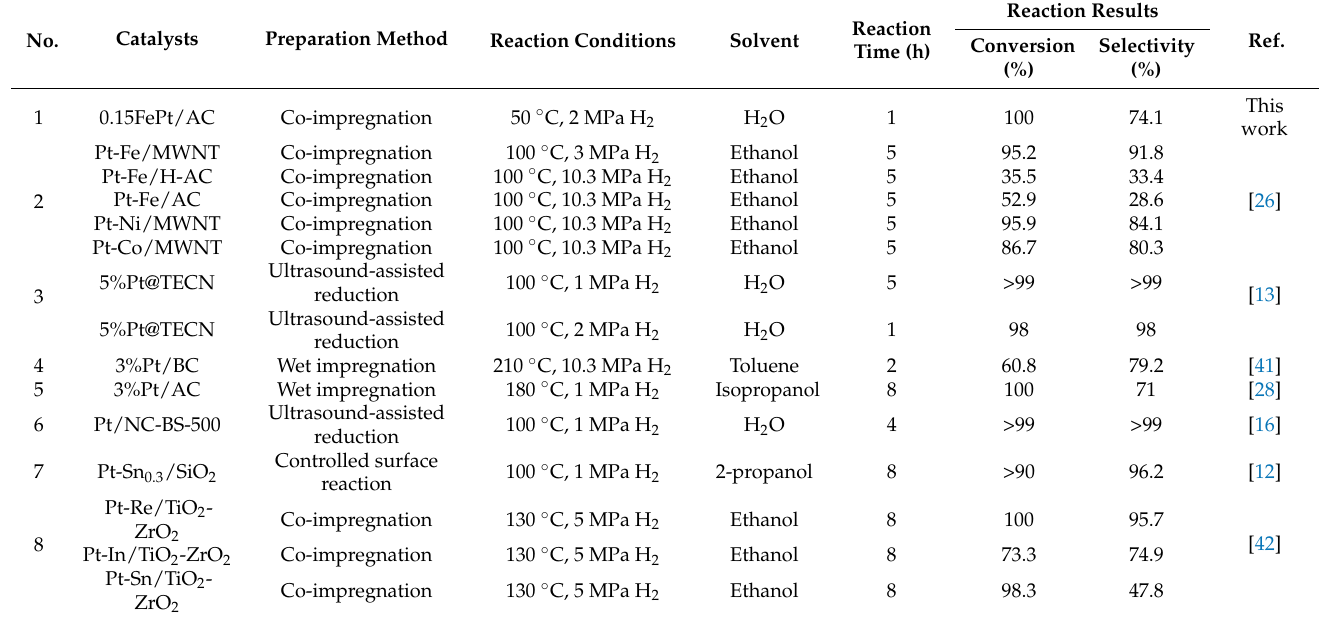
Table 3. Comparison of the prepared catalysts and reported in the literature for the liquid-phase hydrogenation of